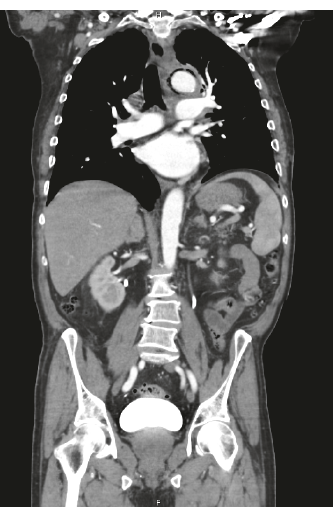
Figure 3: CT chest (coronal view) showing emphysematous aortitis.